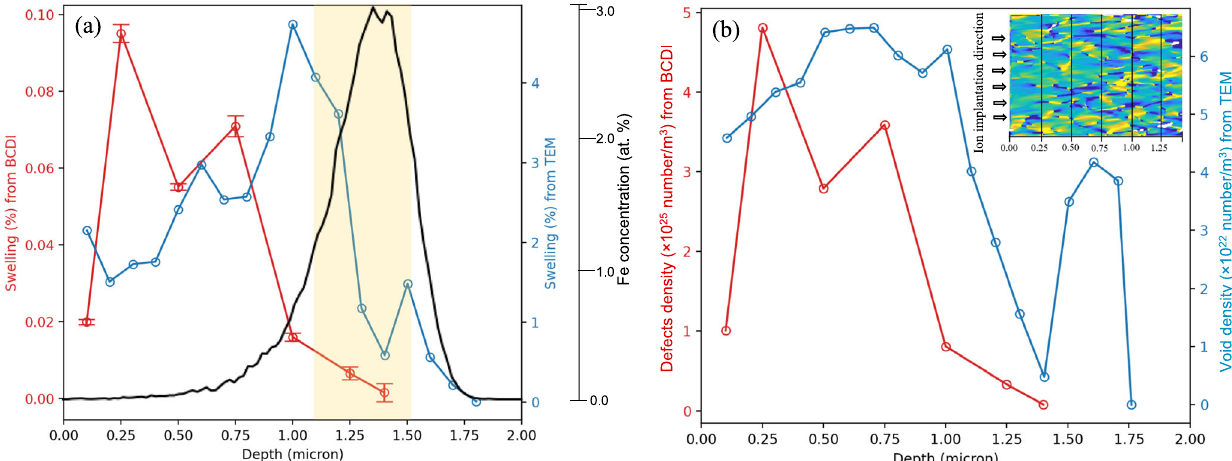
Fig. 6 Swelling and defects density pro fi le estimated from lattice strain. a SRIM-predicted Fe implant distribution for 100 peak dpa irradiation superimposed on the swelling pro fi le as a function of depth in pure chromium irradiated at 550 °C to 100 peak dpa. The box indicates the region of maximum compositional alteration by Fe implantation. b void densities as a function of depth. The inset shows the depth at which the strain data are averaged for each irradiation depth. Note — The scale bar for swelling from BCDI and TEM are different and are adjusted for best visualization of the